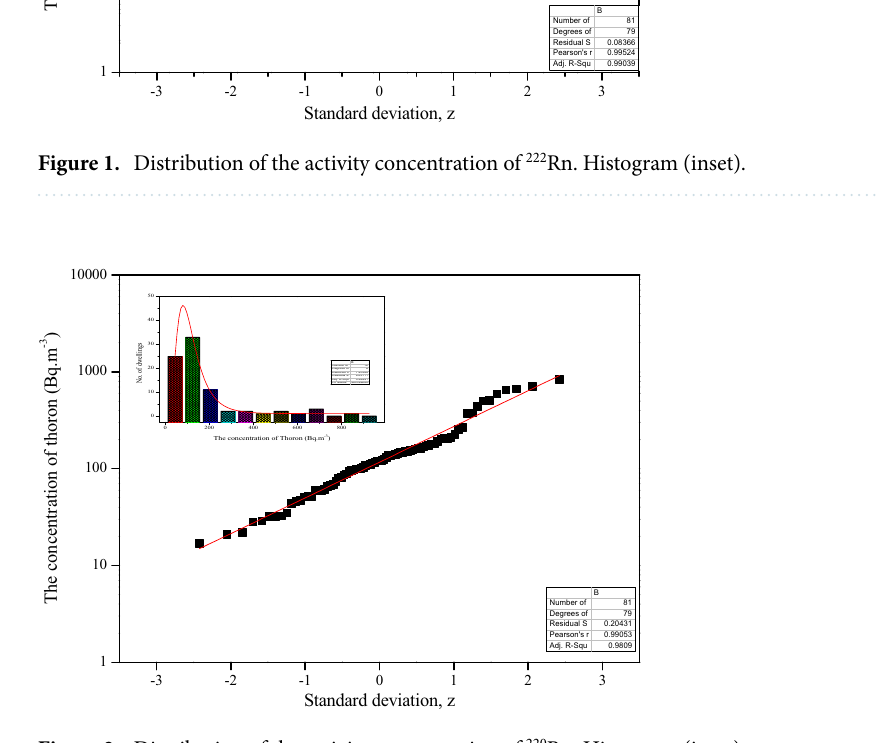
Figure 2. Distribution of the activity concentration of 220 Rn. Histogram (inset).